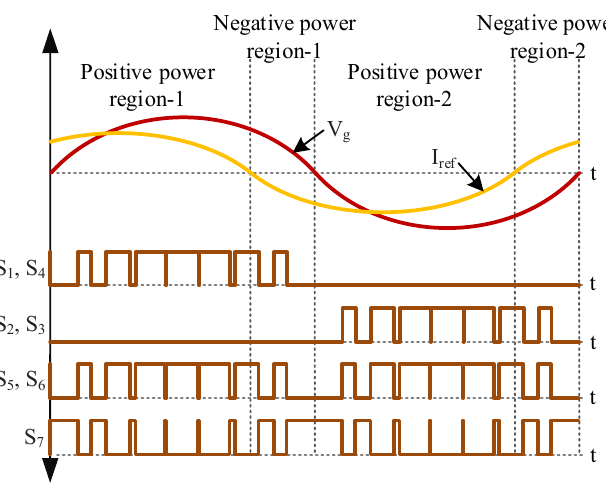
Figure 8. Different power regions and corresponding switching pulses. Figure 9a–d. In the positive power region 1, modes 1 and 2 simultaneously generate + V DC and 0 again. Modes 2 and 4 are freewheeling modes and act to remove overflow of the leakage current. Here, modes 1 and 2 are the active